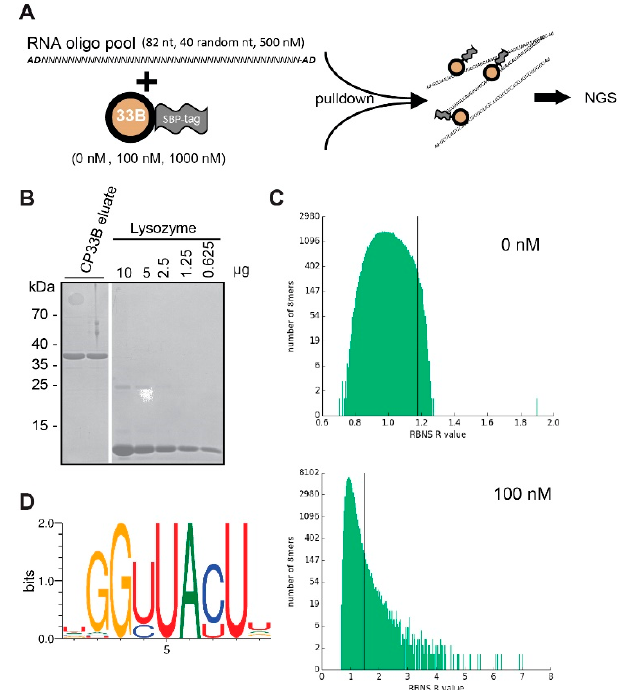
Figure 4. RBNS of CP33B. ( a ) Schematic overview of the RBNS experiment. ( b ) Coomassie stain of an analytical PAGE to determine the amount of SBP:CP33B in two replicate eluates after protease ‐ based removal of the GST tag. The white line indicates where lanes irrelevant for this analysis were removed. ( c ) Stacked histogram showing the distribution of RBNS R values of all RNA 8mers in the CP33B experiment at a protein concentration of 0 and 100 nM, respectively. 8mers with R values that have z ‐ scores equal or greater than two times the average are found on the right of the black lines. A log scale is used for the y axis. Please note the different scales for the X ‐ axes between the two graphs. ( d ) CP33B consensus motif generated from all 8mers with a z ‐ score ≥ 3 in the 100 nM library (detailed rules on motif generation found in [41]).